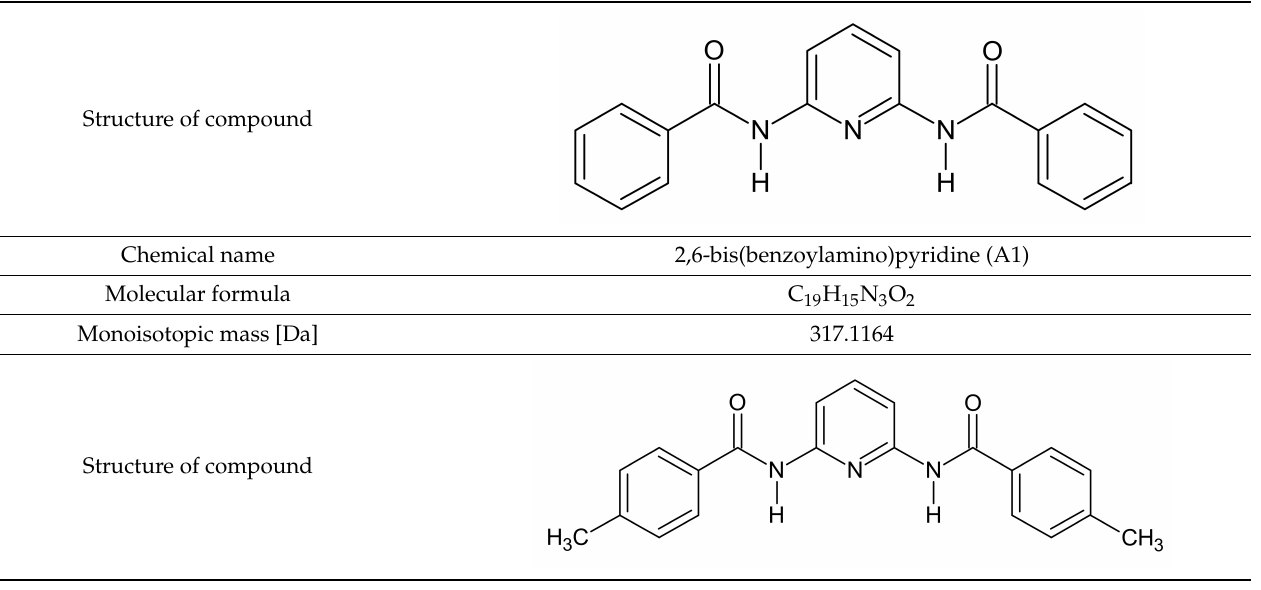
Table 1. The properties of the A1–A3 compounds